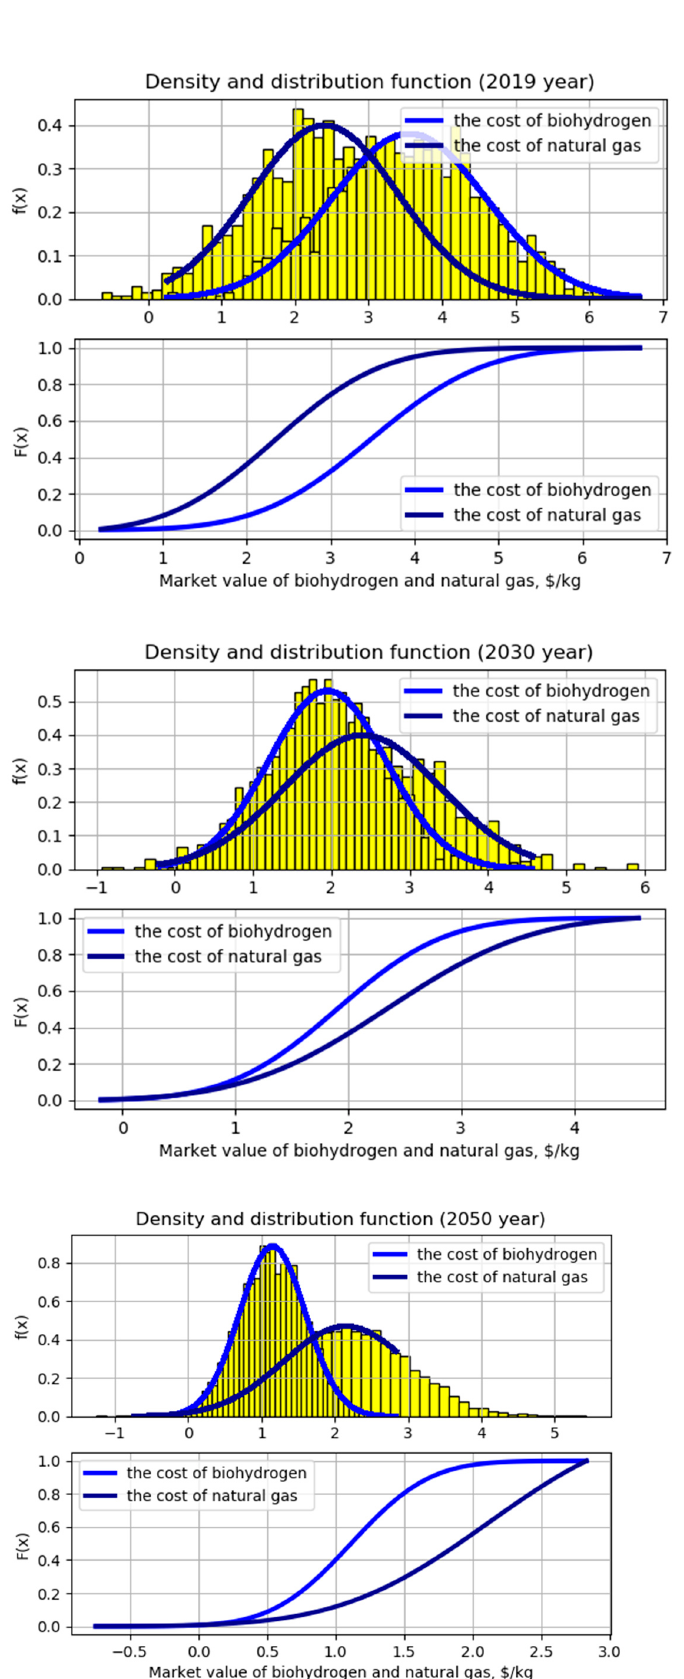
Figure 3. Density and function of market value distributions of biohydrogen from agricultural waste and natural gas.